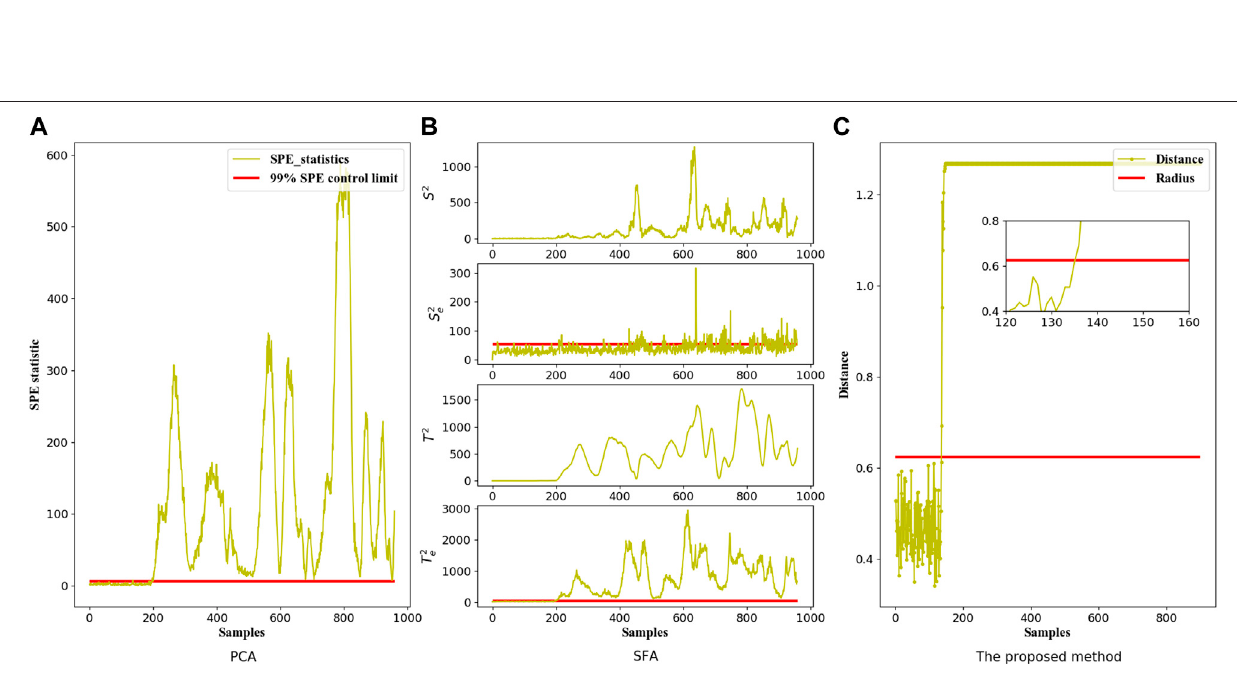
Frontiers in Chemical Engineering |